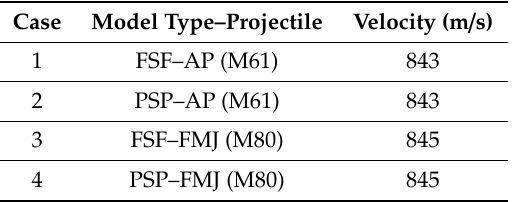
Table 3. Bullet velocities considered for each case of analysis.